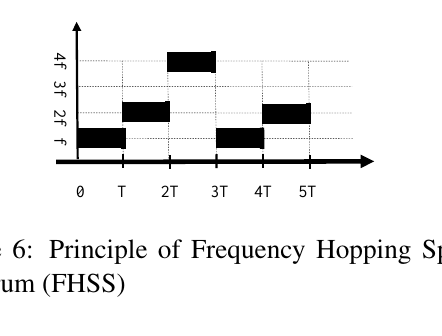
Figure 6: Principle of Frequency Hopping Spread Spectrum (FHSS)